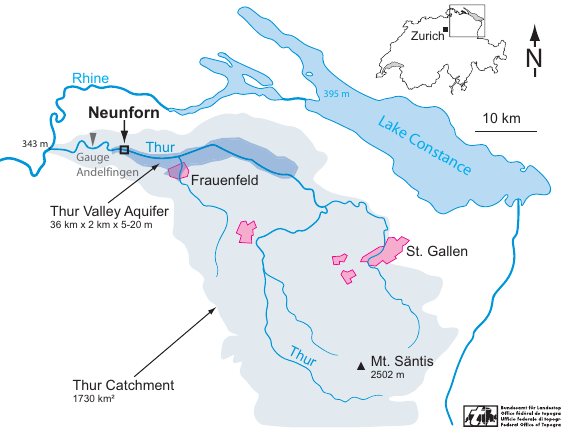
Fig. 1. Location of the Thur catchment, Thur valley aquifer, and Neunforn test site in northeastern Switzerland. Modified from a figure prepared by Swisstopo (Swiss Federal Office of